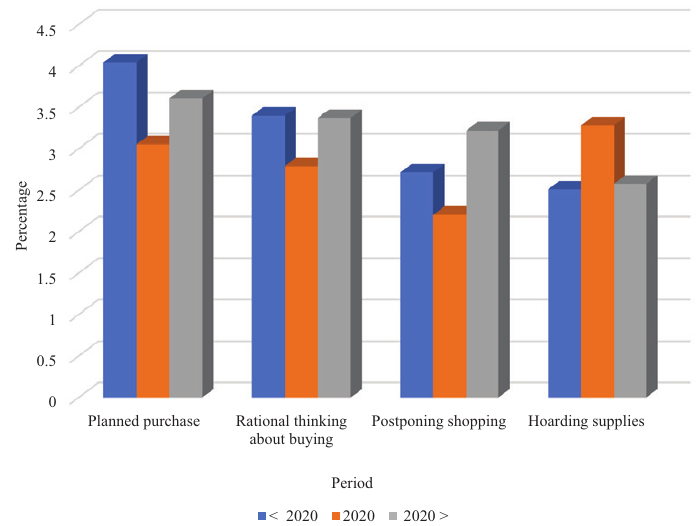
Figure 2. Changes in consumer behavior and in the impulsiveness of purchases in the period before, during and after lockdown (source: prepared by